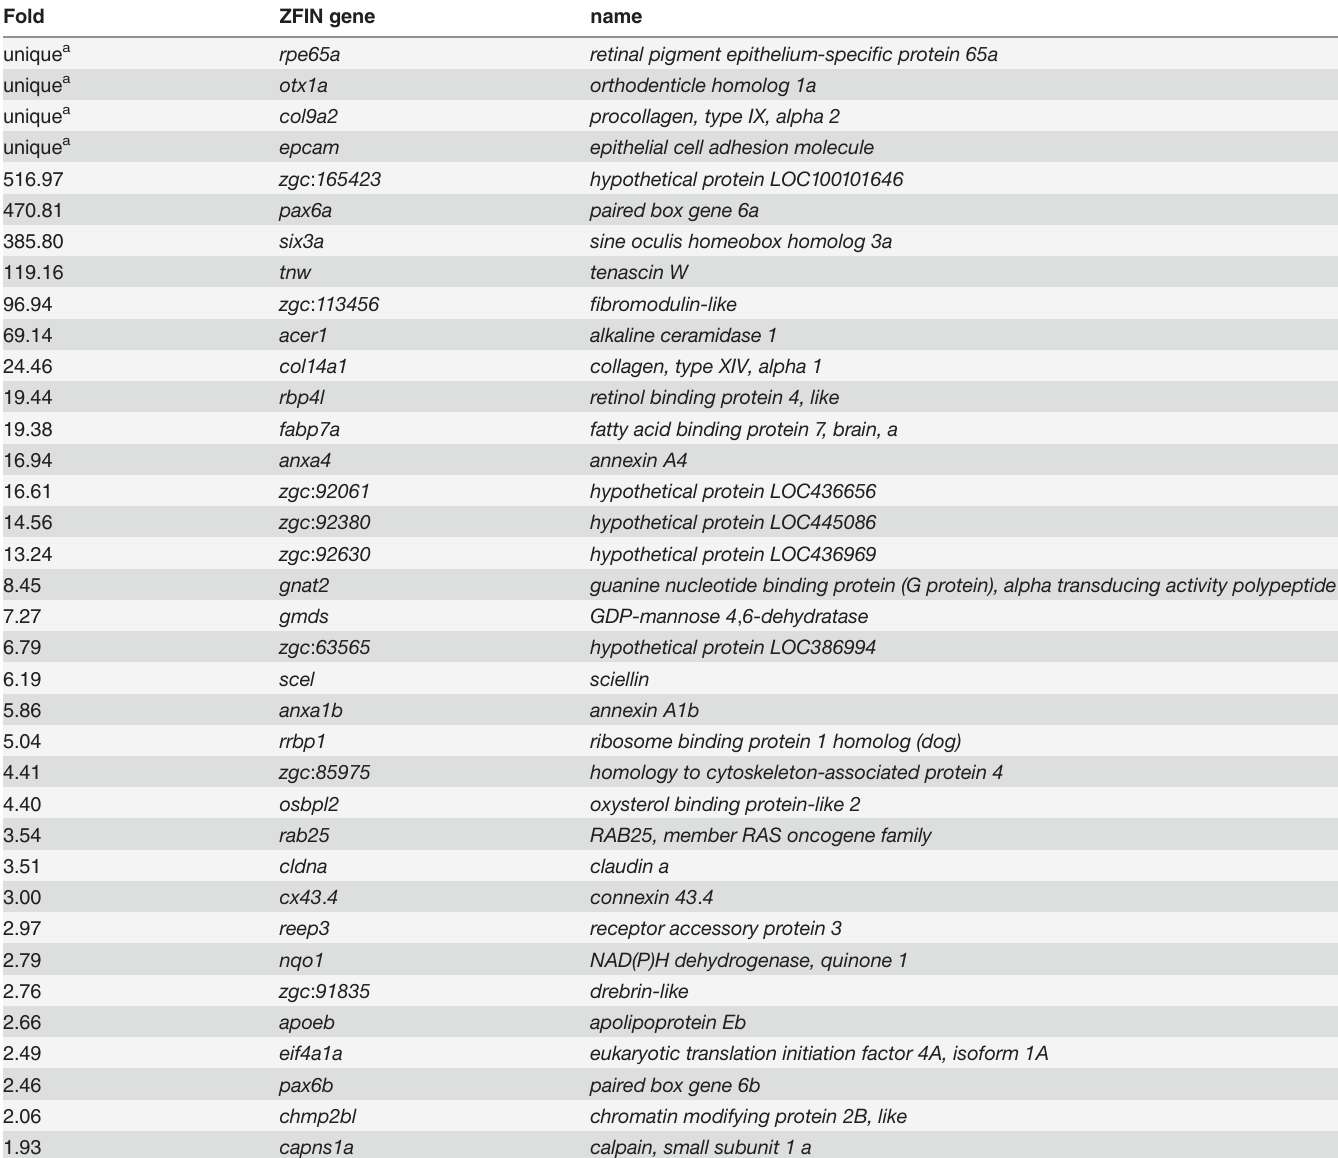
Table 1. RT-qPCR veri fi cation of the microarray data